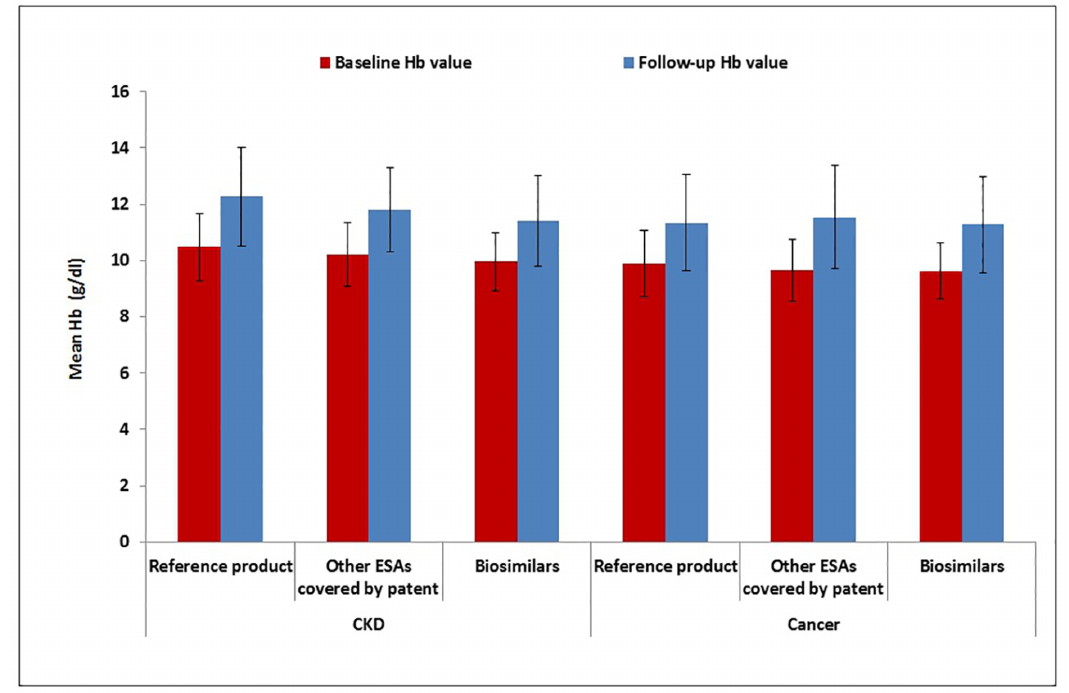
Fig 3. Effect of ESAs on Hb measurements within the follow-up Hb value from the start of the treatment, stratified by indication for use. Hb = hemoglobin; CKD = Chronic kidney disease; ESAs = Erythropoiesis-stimulating